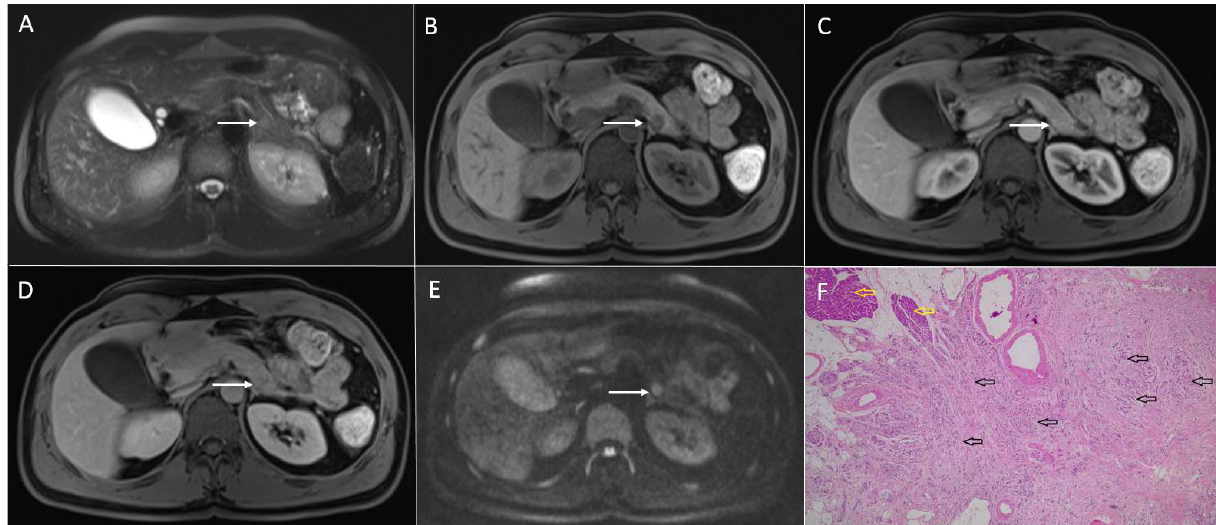
Figure 5. Thirty-five-year-old man with neuroendocrine tumor. On T2-weighted FS image ( A ), the tumor is hardly visible as slight hyperintense lesion in the posterior aspect of the pancreatic body ( arrow ). The tumor is clearly seen on T1-weighted native FS image ( B ), as hypointense lesion ( arrow ). In arterial ( C ) and portal-venous phase ( D ), the tumor is not visible as it enhances to the same degree as the surrounding pancreatic parenchyma. The lesion displays high signal intensity on DWI ( E ). Hematoxylin and eosin (H&E) staining ( F ) showed neuroendocrine tumor G2 with marked desmoplastic reaction ( black arrows ). Normal pancreatic parenchyma is also shown ( yellow arrows ); original magnification ×400.